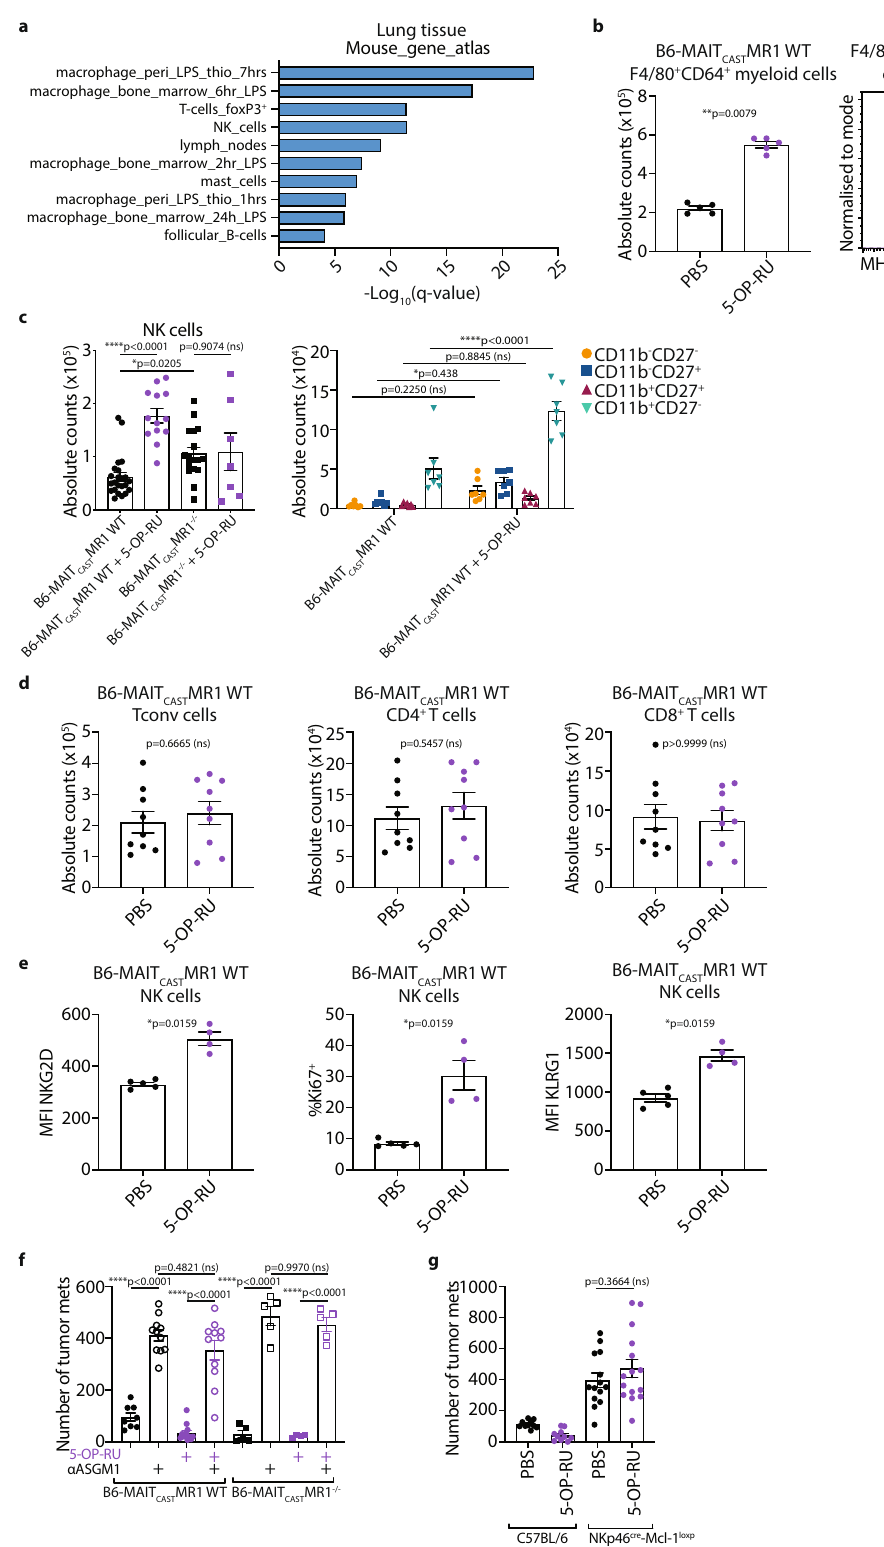
occur within a tumor context (Fig. 6h). Taken together, this data suggests that in a patient setting MAIT cells can negatively impact NK cell anti-tumor functions. However, activation of MAIT cells can overcome this inhibition by enhancing NK cell